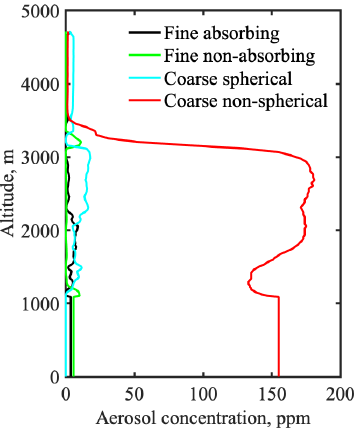
Figure 33. Vertical profile of aerosol extinction at 355nm re- trieved from LILAS observations using stand-alone (red) and multi- temporal approaches (blue) performed on 16 April 2015 in compar- ison with estimation from 355 / 387nm inelastic backscatter mea- surements